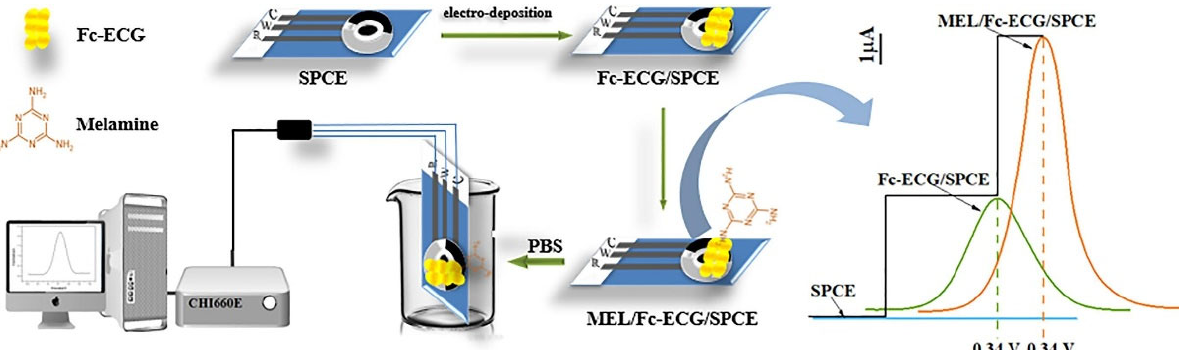
Figure 15. The process of making an Fc ‐ ECG/SPCE sensor for MEL detection (Reprinted with permission from Ref. [63]. 2022, An et al.).